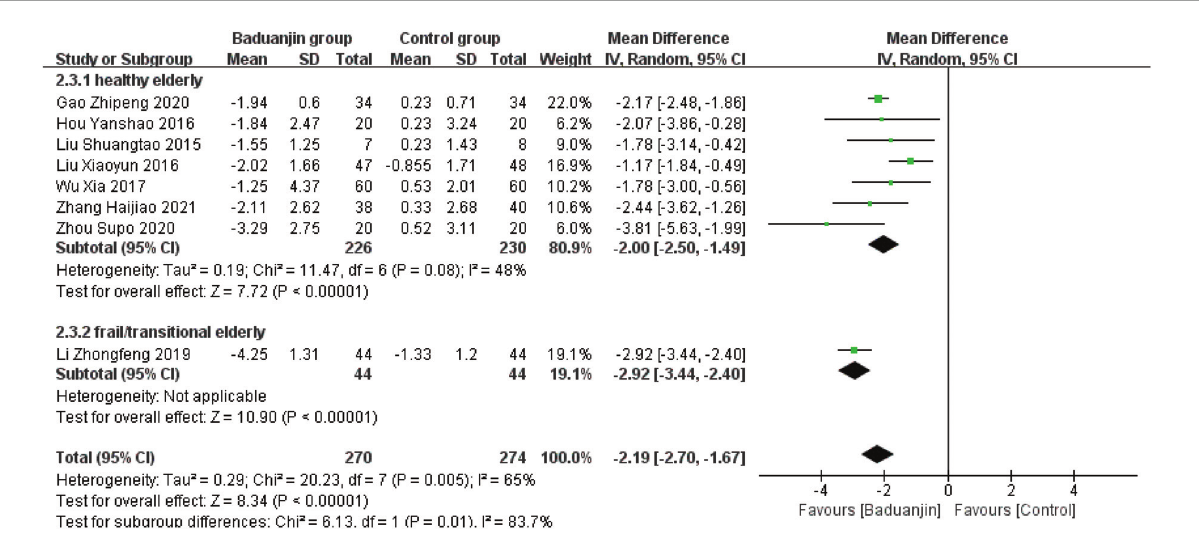
FIGURE7 Forest plot of the subgroup analysis of TUG for the different health status. CI, confidence interval; SD, standard deviation.